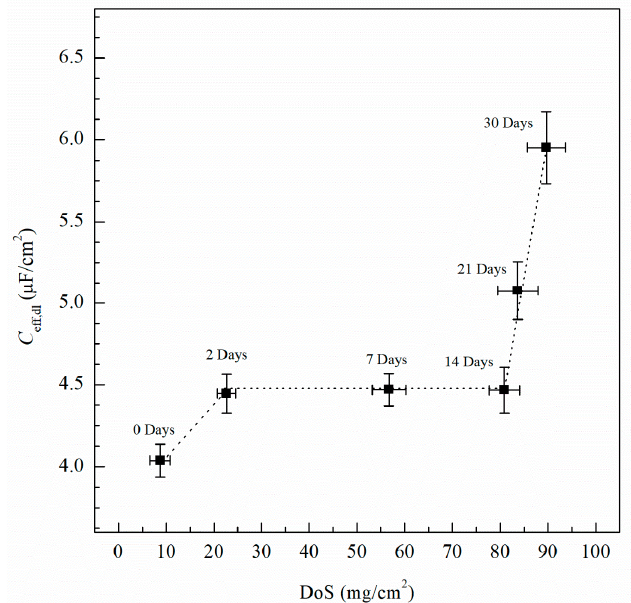
Figure 13. E ff ective capacitance values of the double layer ( C e ff ,dl ) calculated from EIS fitting data using Figure 13. Effective capacitance values of the double layer ( C eff,dl ) calculated from EIS fitting data using Equation (3). Error bars represent standard deviation from the Equation (3). Error bars represent standard deviation from the mean.